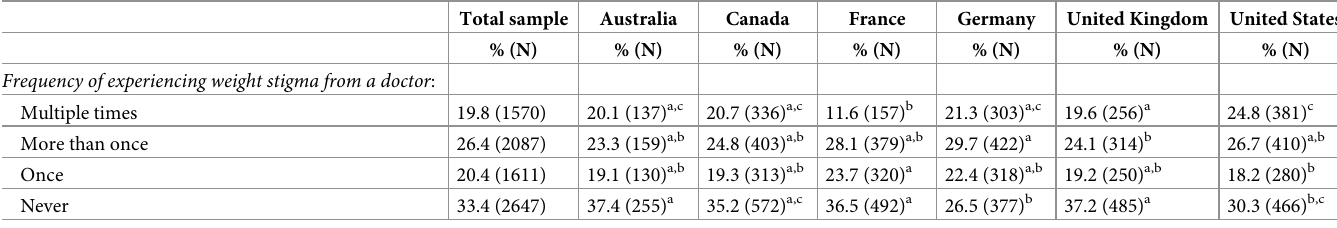
Table 1. Frequency of experiencing weight stigma from